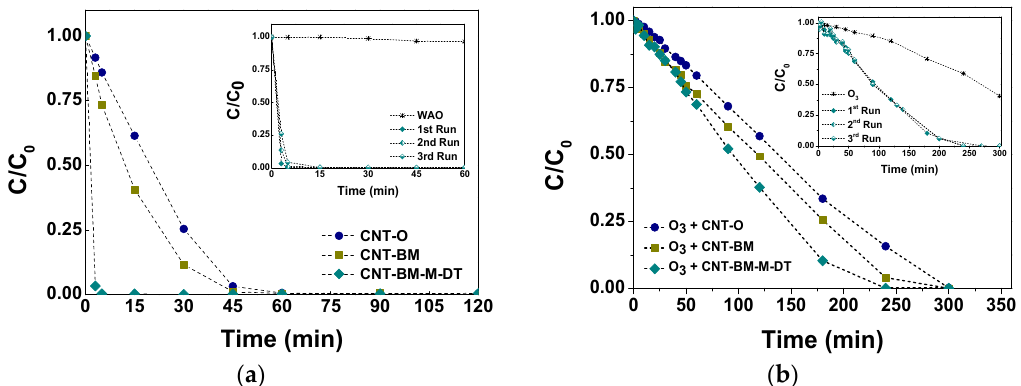
Figure 9. Evolution of the normalized oxalic acid concentrations: ( a ) in CWAO experiments (T = 140 °C, P T = 40 bar (P O2 = 7 bar), 0.1 g of catalyst; [Oxalic Acid] o = 1000 mg/L) and ( b ) in COZ (T Room , 0.05 g of catalyst; [Oxalic Acid] o = 450 mg/L) and cyclic experiments inset using sample CNT-BM-M-DT. (Non-catalytic conditions (WAO), single ozonation (O 3 ), original (CNT-O), ball milled (CNT-BM) and sample doped with melamine (CNT-BM-M-DT)) (Adapted from [52]).